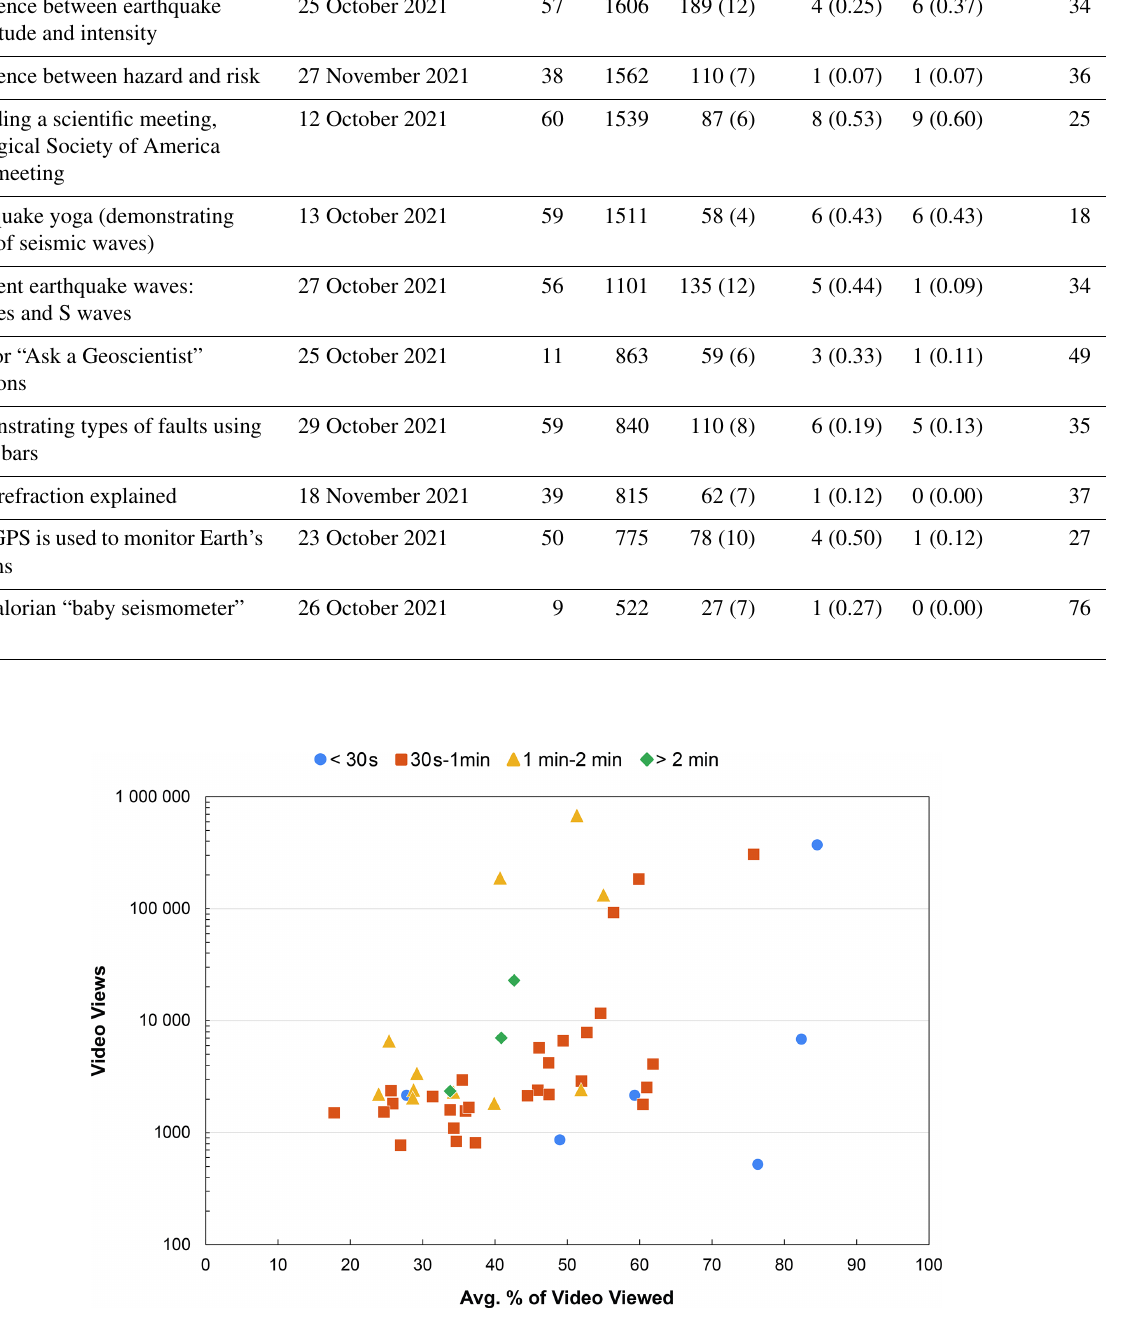
Figure 5. Average percentage of the video viewed based on the length of the video ( < 30s, 30s to 1min, 1 to 2min, and > 2min) compared to the number of video views. Note that video views are shown on a logarithmic scale. There is a weak positive correlation that is statistically significant ( r = 0.37, p = 0.008). See Supplement for full correlation